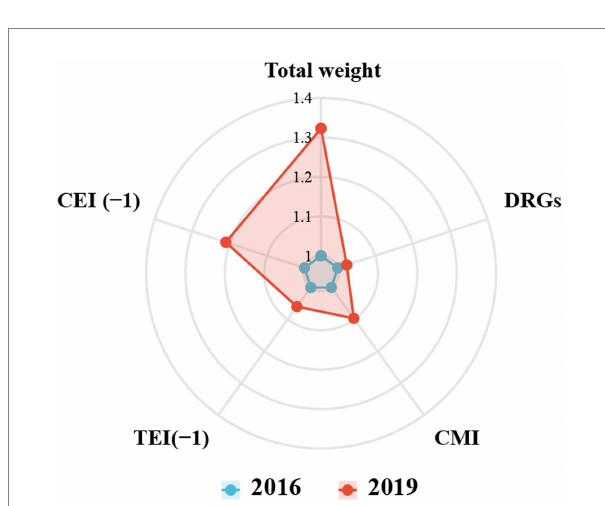
FIGURE 3 Comparison the medical service performance for department of organ transplant between 2016 and 2019. DRGs, diagnosis-related groups. CMI, Case Mix Index. TMI, time efficiency index. CEI, charge efficiency index.